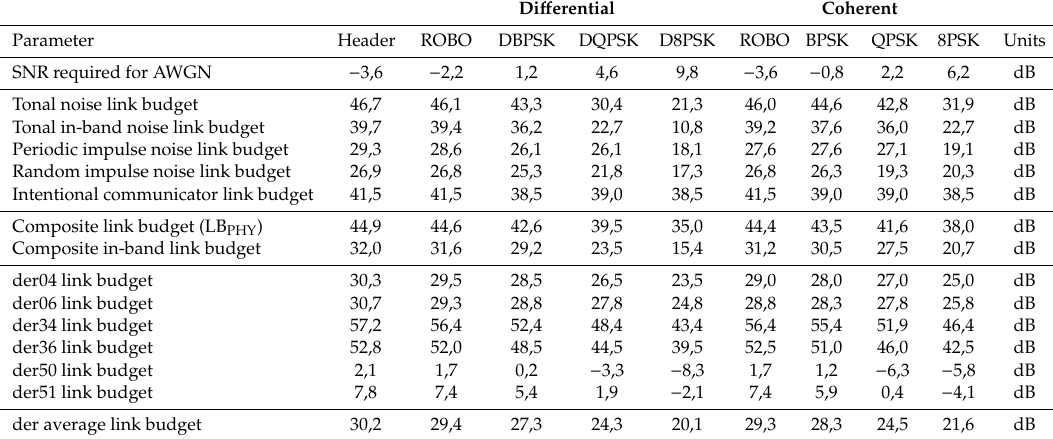
Table 9. Absolute results with the standard tone map implemented in G3-PLC.